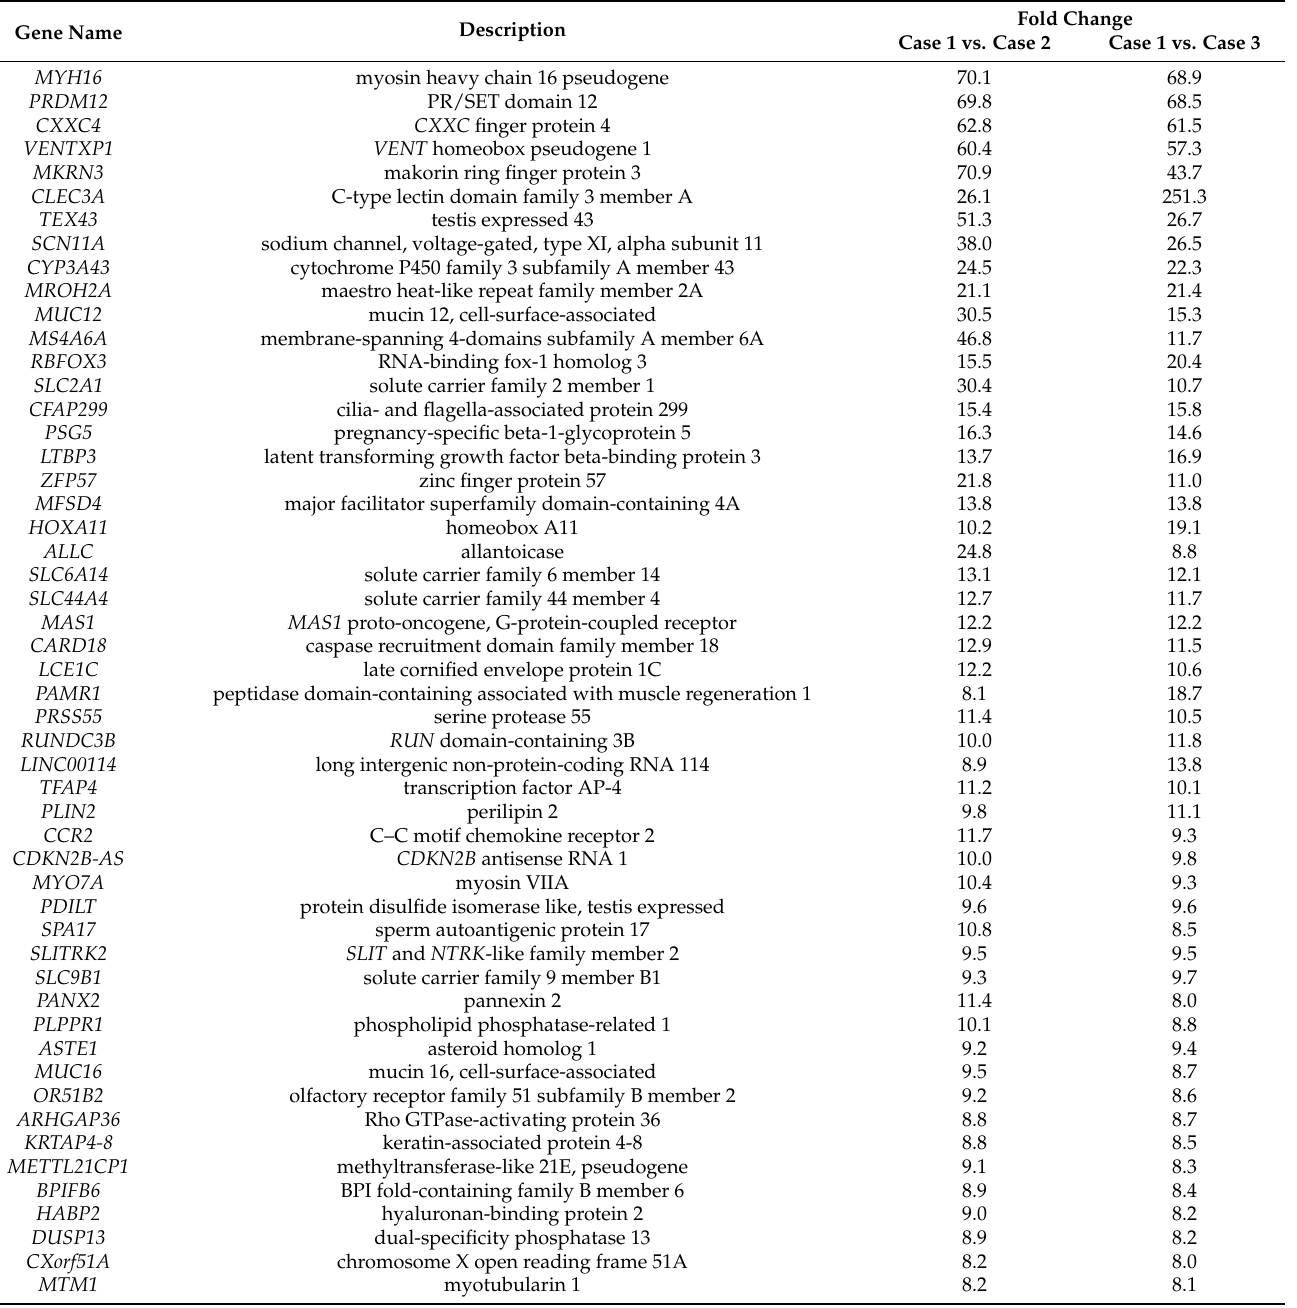
Table 4. Fifty-two genes that overlapped and were enriched (>8-fold) in the tunica media of the patent DA tissue (Case 1) compared to that of the closing DA tissues (Cases 2 and